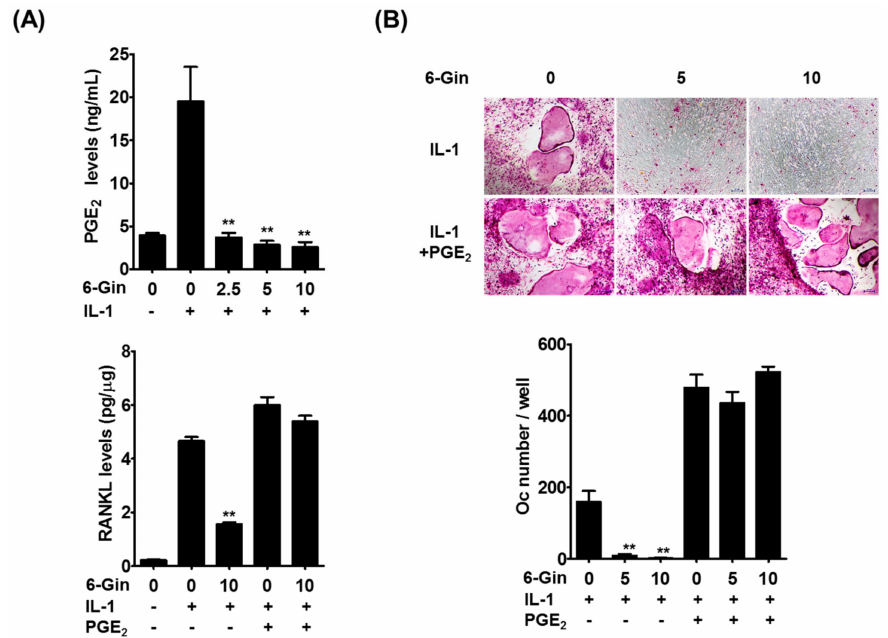
Figure 4. Prostaglandin E 2 (PGE 2 ) reverses the inhibitory effects of 6-gingerol on IL-1-induced osteoclast differentiation. ( A ) POBs were treated with or without IL-1 (10 ng/mL) and 6-gingerol (6-Gin, 2.5–10 µ M) for 24 h. PGE 2 levels in culture media and RANKL levels in cell lysates were determined; ( B ) the co-cultures of POBs and BMCs were incubated with or without 6-gingerol (5 or 10 µ M), IL-1 (10 ng/mL), and PGE 2 (100 nM) for seven days. The number of osteoclasts was counted. ** p < 0.01 vs. treatment with IL-1 alone. Scale bar = 100 µ